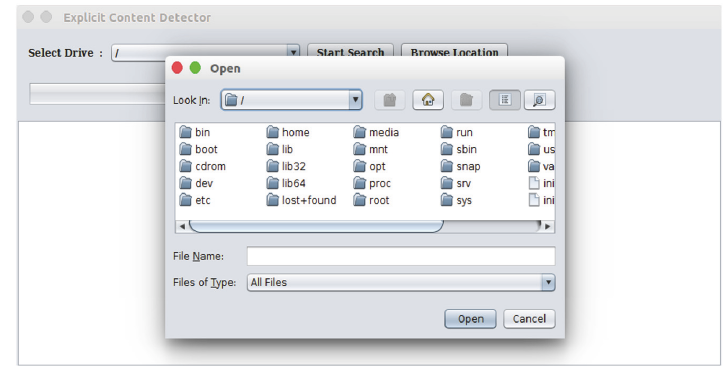
Figure 9: Select the drive/folder to scan for the explicit contents.